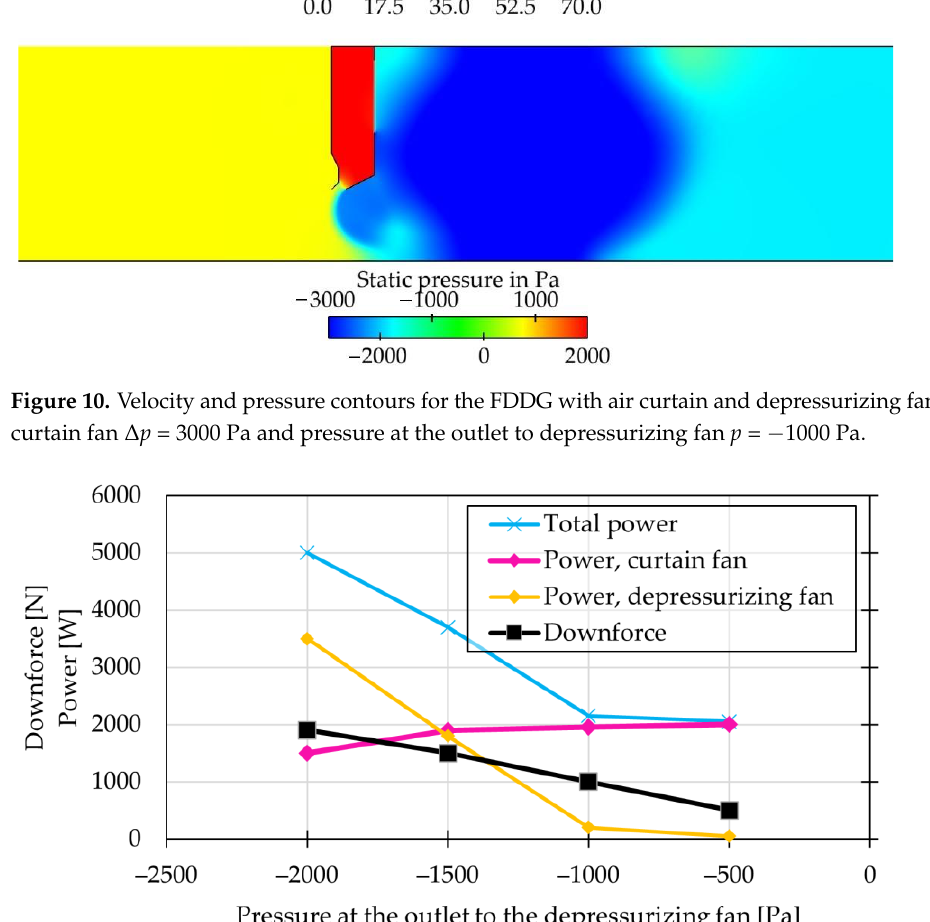
Figure 11. The downforce generated by FDDG and the required power with air curtains and depressurizing fan running as a function of the depressurizing fan compression. The air curtain fan was operating at constant Δ p = 3000 Pa.